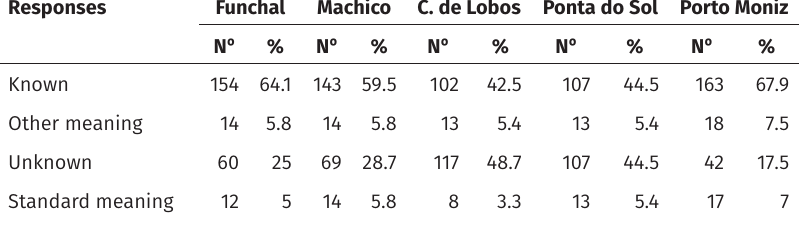
Table 7: Total results of the 30 informants by